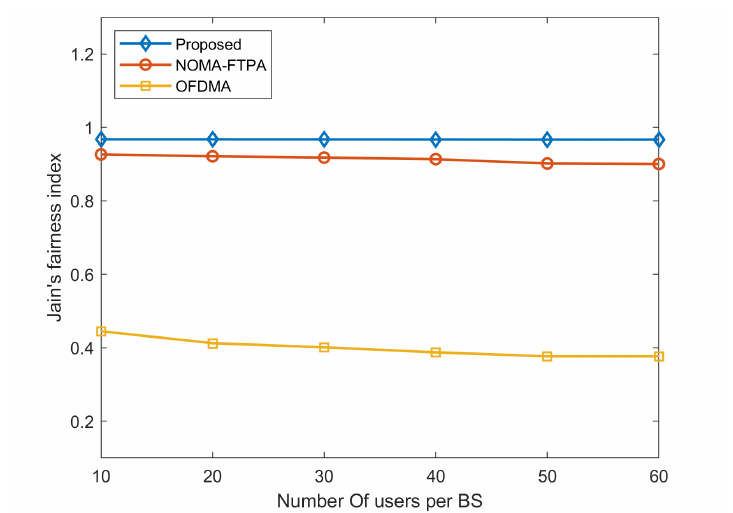
Figure 7. Comparison between different methods in term of